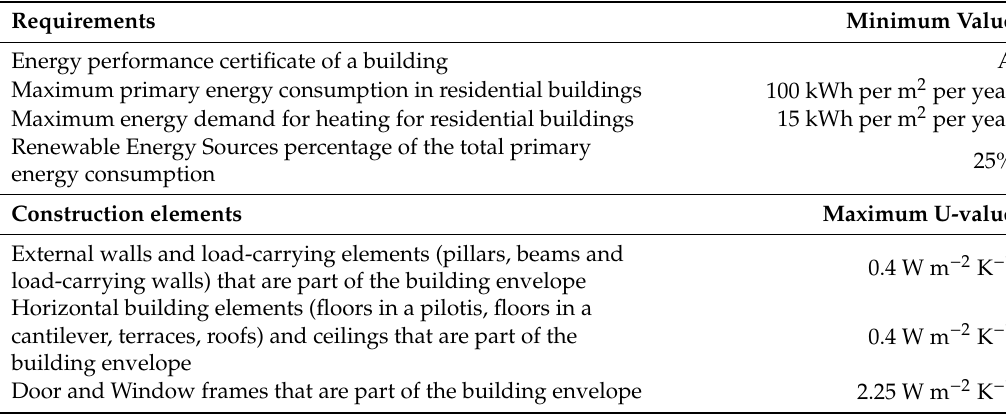
Table 1. Requirements and technical characteristics that must be met by a nearly Zero Energy Building (nZEB) according to Derivative 366/2014, modified from the work in [34].